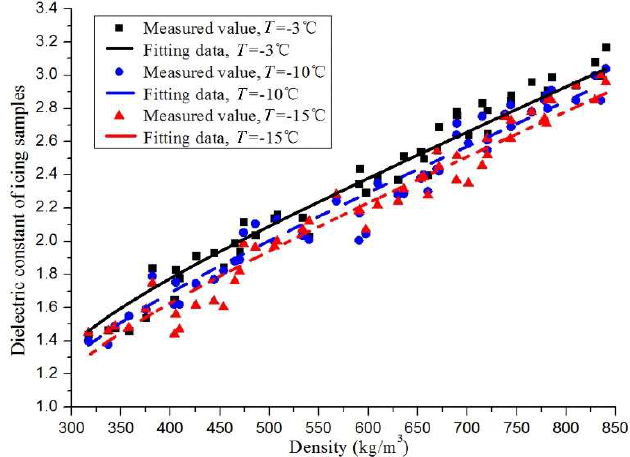
Figure 10. The relative dielectric constant of the icing samples under different temperatures.